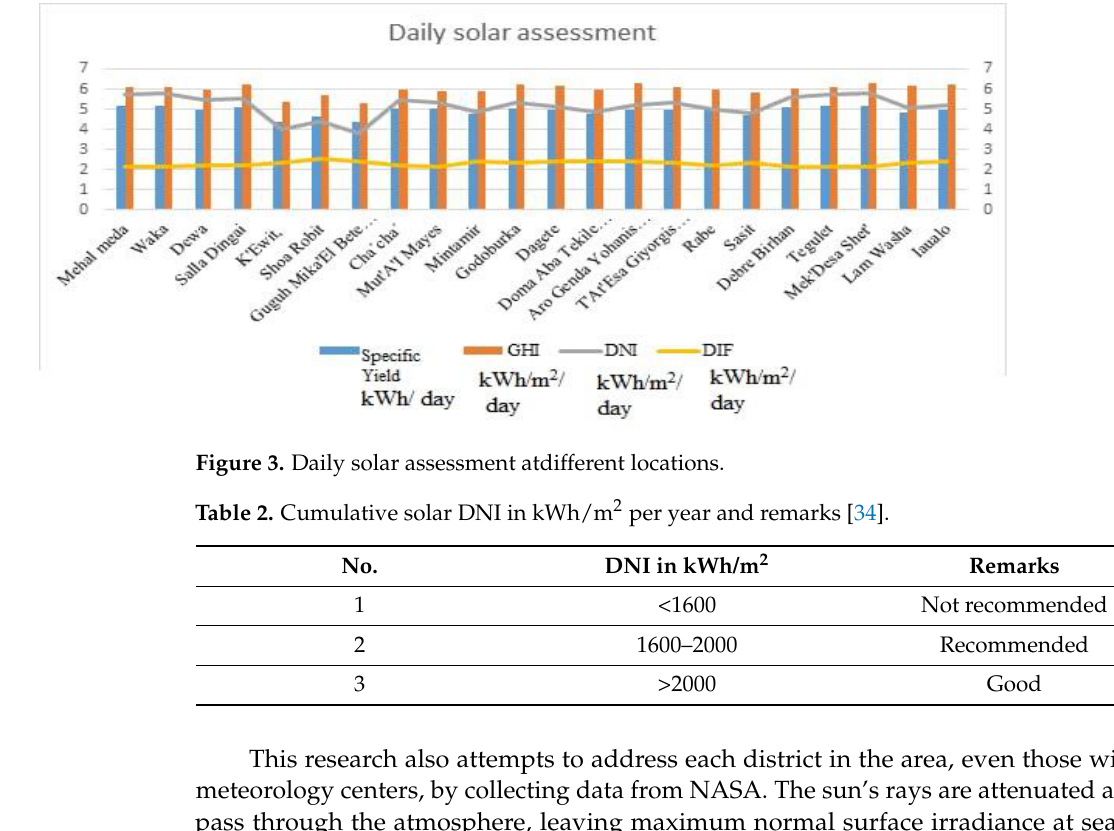
Figure 4. Annual sunshine assessment of North Shewa from the NMA.